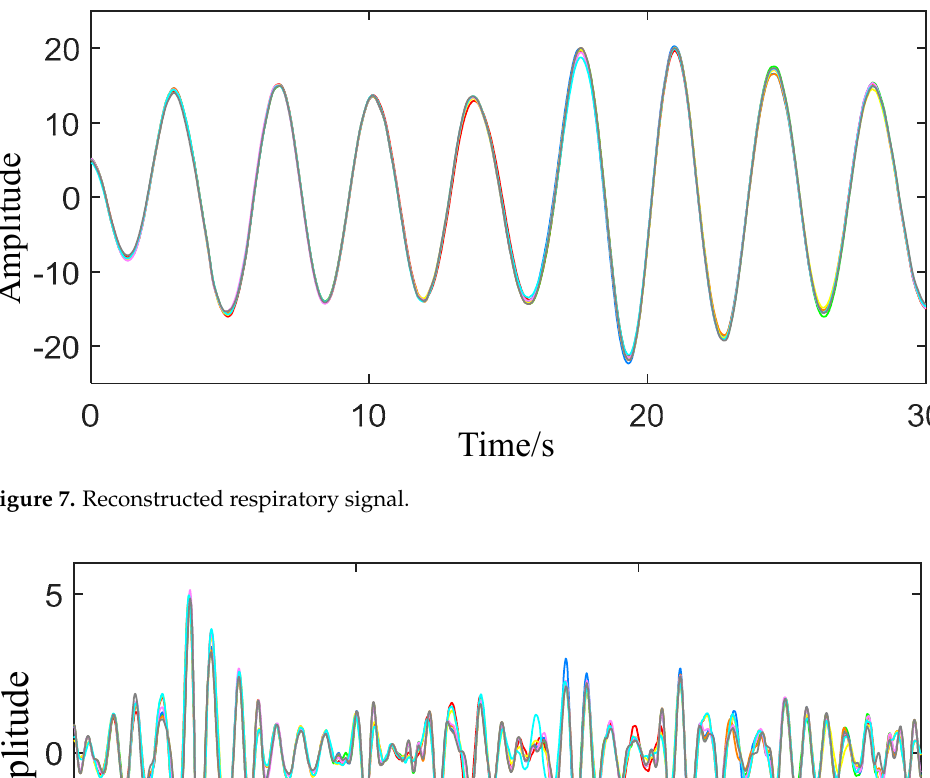
Figure 8. Reconstructed heartbeat signal.